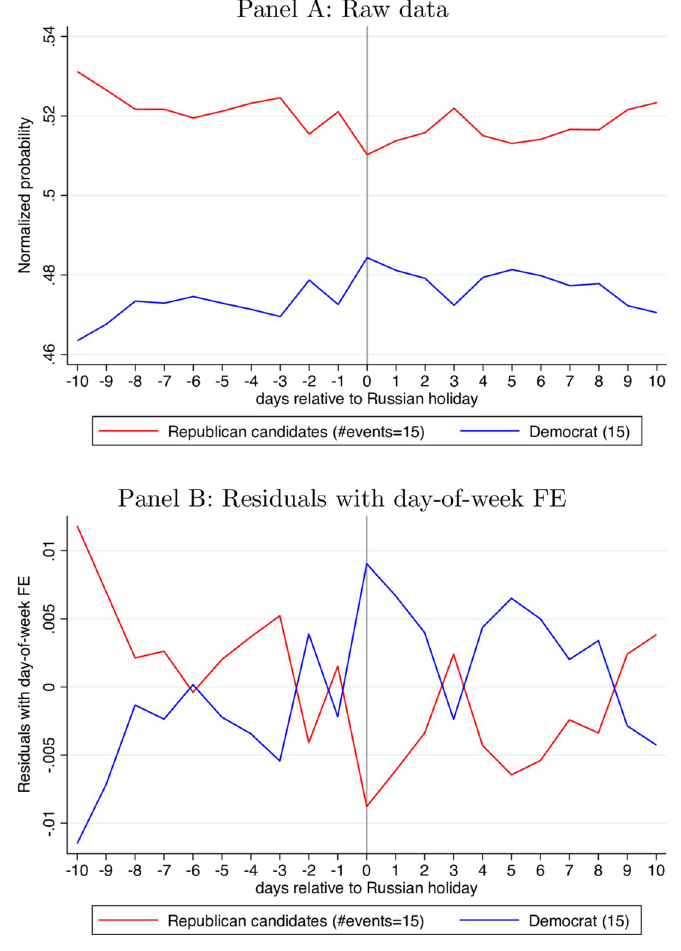
Fig 3. Event study of PredictIt betting odds around Russian holidays Nov 2014–Nov 2016. (There are 16 Russian holidays Nov 2014-Nov 2016. Similar to Fig 1, we only keep holiday events with complete data over the 21-day window. The last holiday, Nov 4, 2016, is dropped due to incomplete betting data). Panel A: Raw data. Panel B: Residuals with day-of-week FE. Panel C: Residuals with day-of-week and year by month FE.